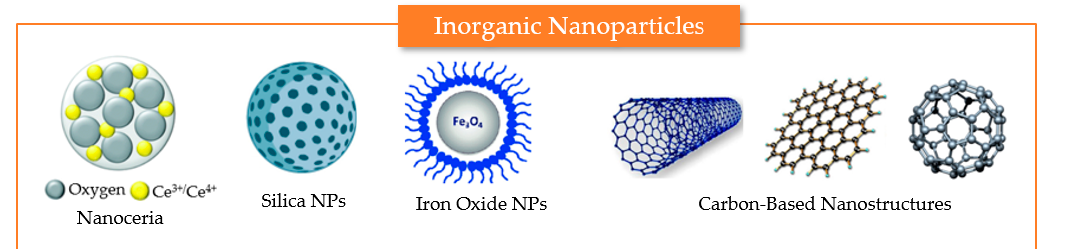
Figure 4. Summary of different nanosystem types employed for drug encapsulation to overcome the limitations of antioxidant delivery in neuronal regeneration from post-COVID-19 damages. Examples of organic delivery vehicles include liposomes, cubosomes, solid lipid nanoparticles, micelles, and polymeric nanoparticles. Examples of inorganic nanoparticles include nanoceria, mesoporous silica nanoparticles, and iron oxide NPs. Carbon-based materials, which lack carbon–hydrogen bonds typical of organic compounds, include various types of nanostructures (e.g., carbon nanotubes, graphene nanosheets, and fullerenes). The properties of the different nanocarriers are described in the